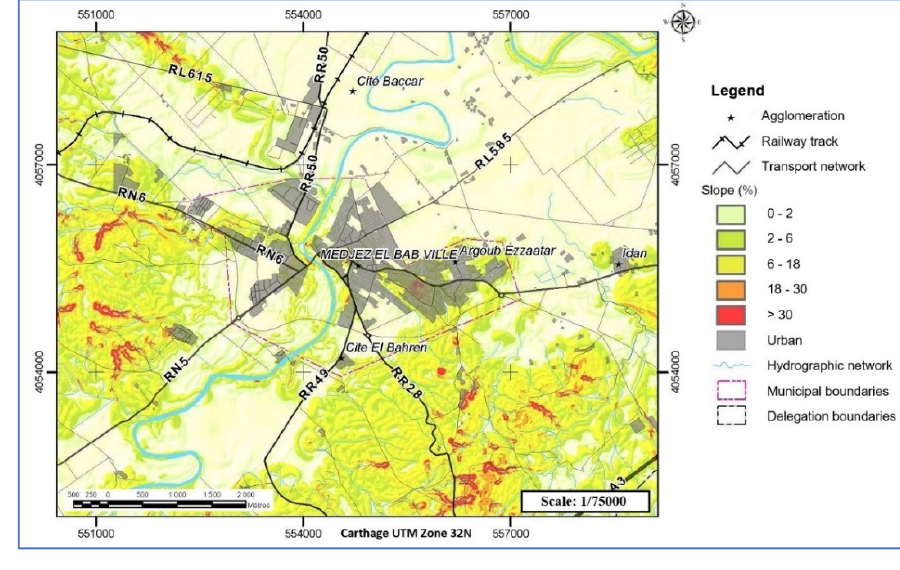
Figure 5. Slope map.